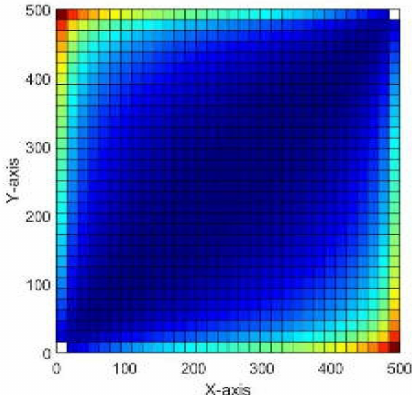
Figure 2. Total travel time to illustrate the areas of high speed flow and those of stagnant